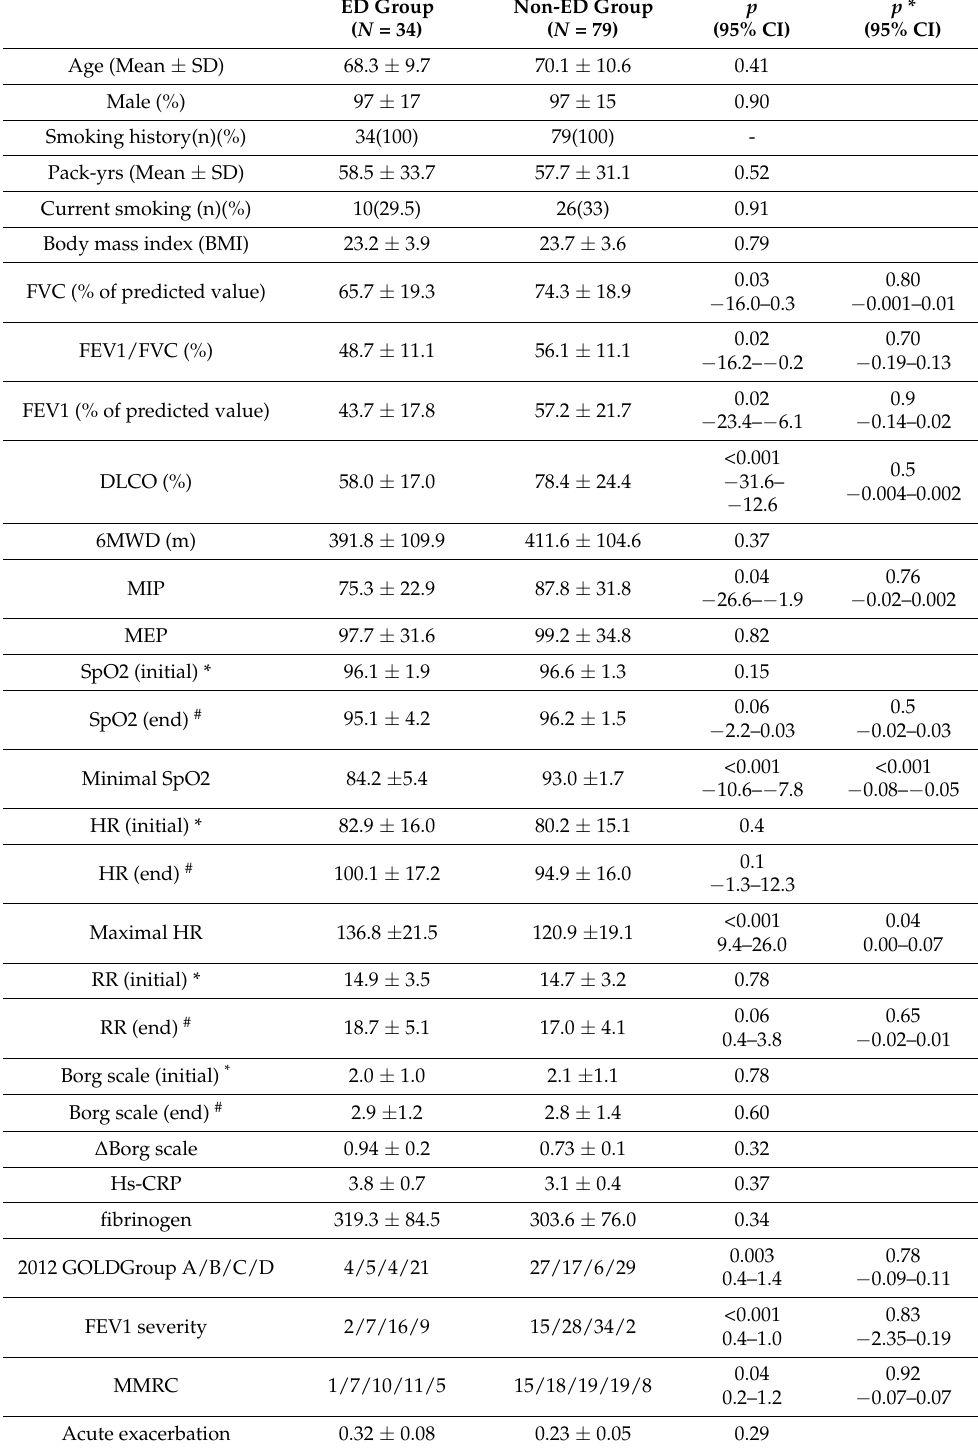
Table 2. Comparison of the characteristics of the ED and non-ED groups by univariate ( p -value) and multivariate ( p *-value)